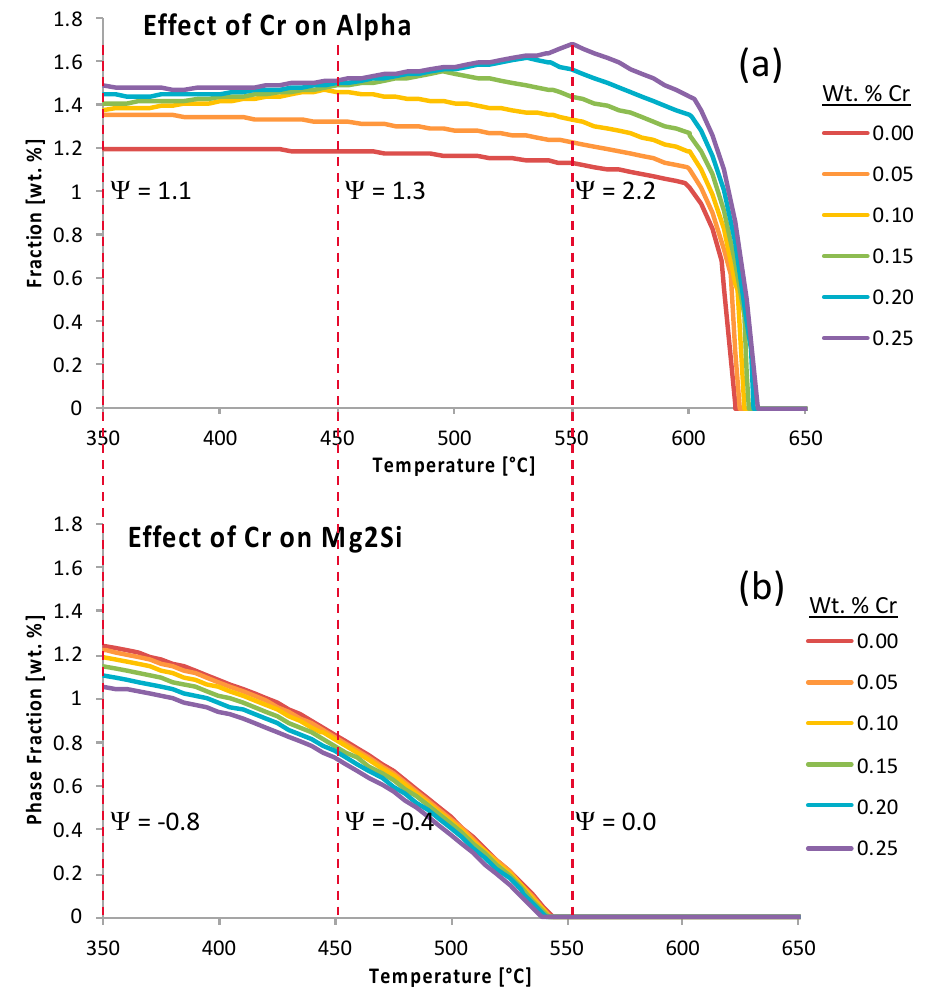
Figure 16. ( a ) The fractional weight percent of alpha as a function of temperature and the weight percent of chromium relative to the Al 6061 system. ( b ) The effect of chromium on the phase fraction of Mg 2 Si as a function of said alloying element and temperature . Materials 2020 , 13 , x FOR PEER REVIEW